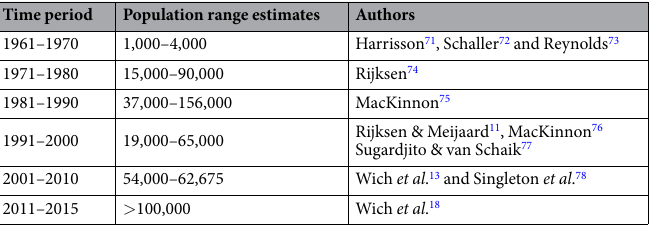
Table 1. Total population estimates of the Bornean orangutan ( Pongo pygmaeus ) made by various